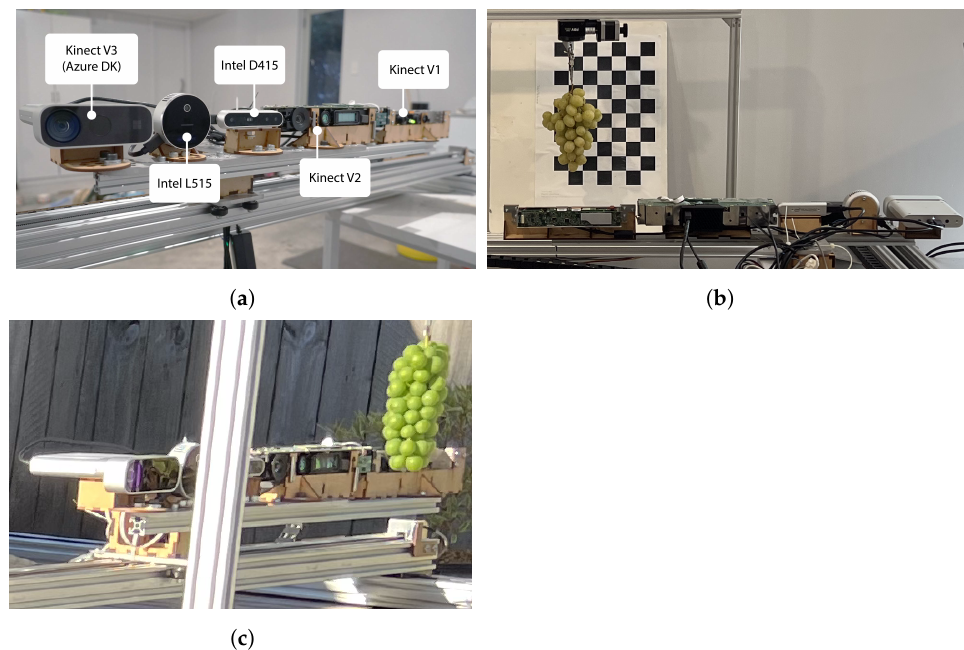
Figure 2. Photos of the experimental setup. Photo ( a ) shows the front view of the cameras mounted onto the 2D gantry. Photos ( b , c ) respectively show the setup located inside and